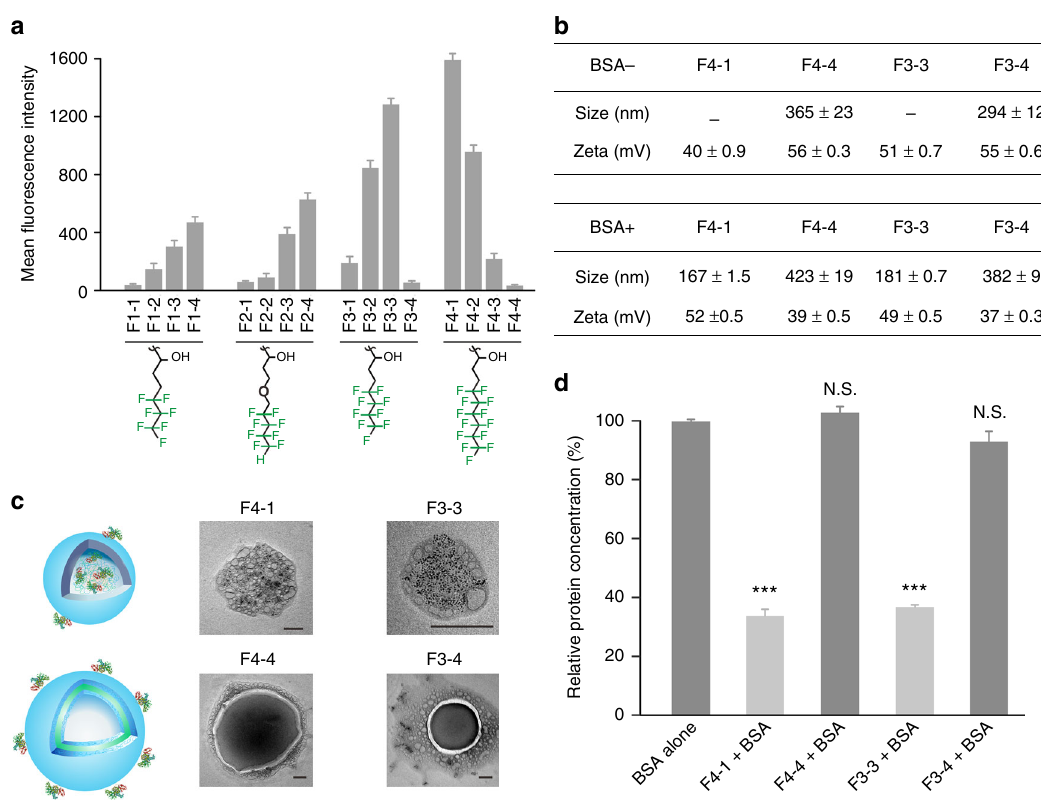
Fig. 4 Structure-activity relationships of fl uoroamphiphiles. a Mean fl uorescence intensity of HeLa cells transfected with nanocomplexes for 4 h at optimal conditions. The cells were treated with trypan blue before fl ow cytometry measurement. Data are presented as mean ± s.e.m. ( n = 3). b Size and zeta- potential of fl uoroamphiphiles and their complexes. Data are presented as mean ± s.d. ( n = 3). A representative result from three independent experiments. c TEM images of fl uoroamphiphiles complexed with Pt-labeled BSA. The polymer to protein molar ratio in b and c is 1:1. The scale bar is 100 nm. d BCA assay for the nanocomplexes. Free BSA was tested as a control. Data are presented as mean ± s.e.m. ( n = 5), N .S. p > 0.05 and *** p < 0.001 analyzed by Student ’ s t -test, one